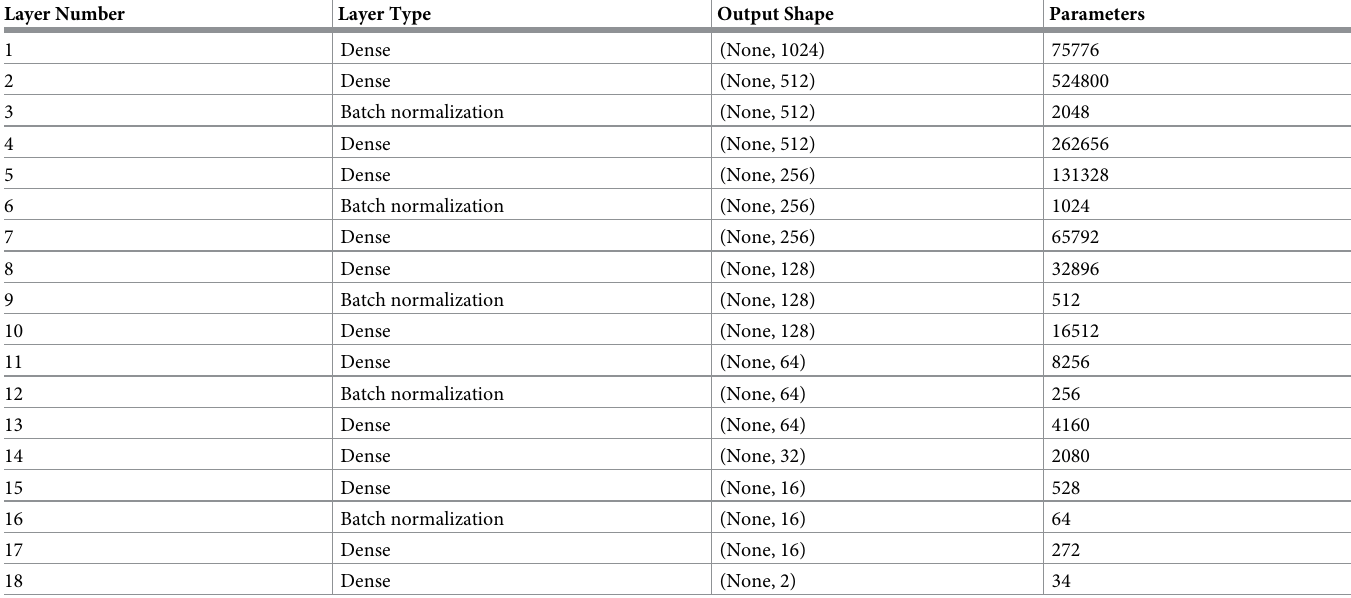
Table 1. Neural network